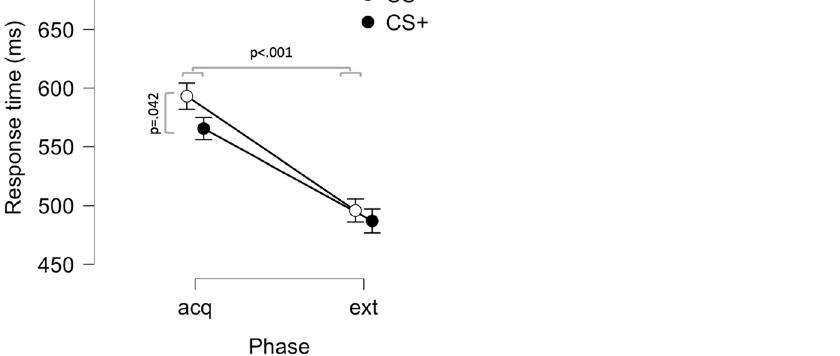
Figure 4. Response times to early auditory probes during presentation concomitant with conditioned stimuli (CS) in the acquisition (acq) and extinction (ext) phases. Response time to stimuli paired with an aversive outcome (CS +) was faster than to stimuli never paired with an aversive outcome (CS−) during acquisition but not extinction. Response times for both stimuli was higher during acquisition than during extinction Points and error-bars indicate means and SEMs.